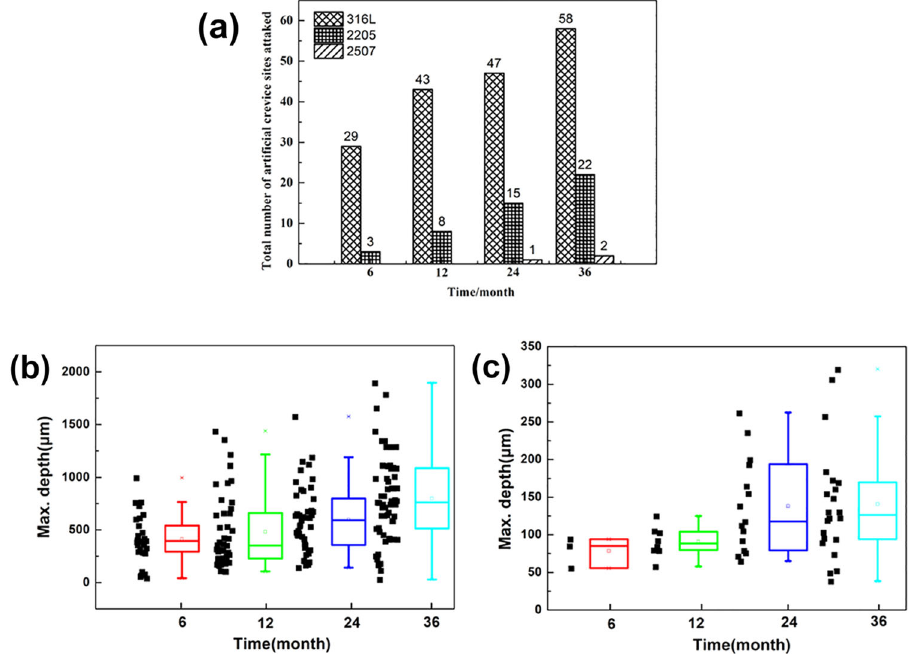
Fig. 4 Statistical results of arti fi cial crevice corrosion on three stainless steels. a Total number of arti fi cial crevice sites attacked, and maximum pit depths of b 316L SS and c 2205 DSS (the box shows the median and IQR, the whiskers indicate maximum and minimum, outliers lie outside this range).